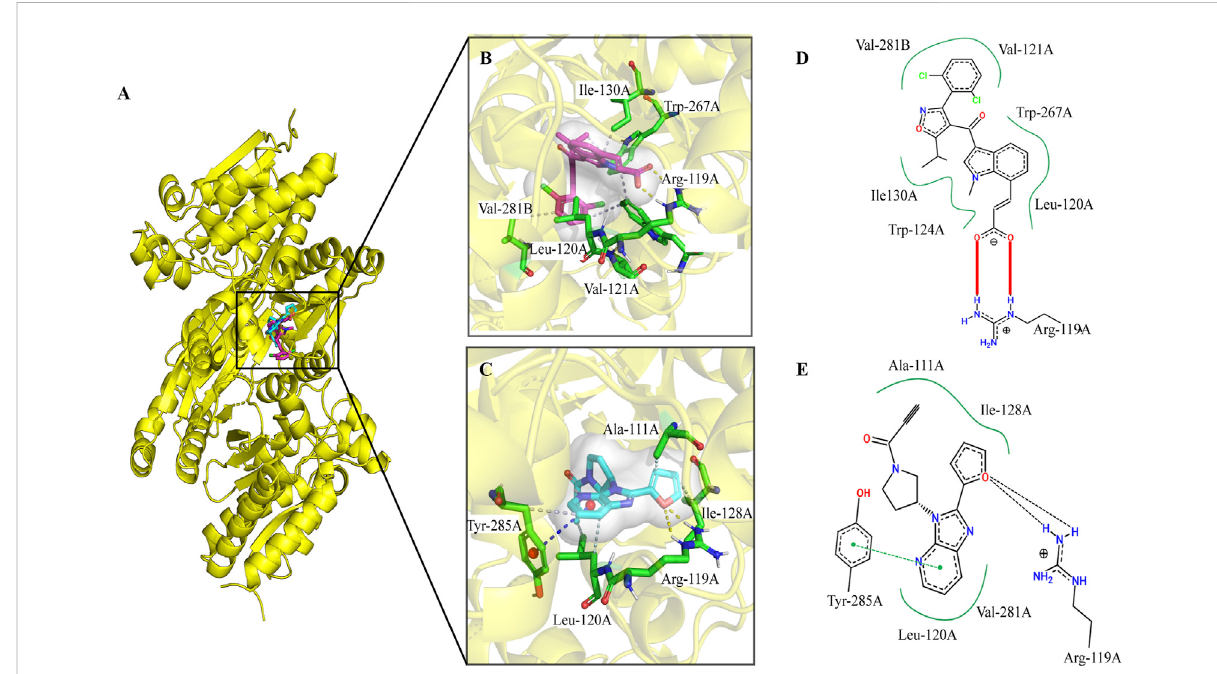
FIGURE 4 ThebindingpocketofcompoundAandT001-0657forIDH1-R132C. (A) Overall fi guresofthebindingofcompoundAandT001-0657to IDH1 - R132C.CompoundAisdepictedasredsticksandT001-0657isdepictedasbluesticks.The IDH1- R132Cisdisplayedincartoonmode(PDBID6IO0). (B,C) A close-up view of the key interactions stabilizing compound A/T001-0657 in the IDH1 -R132C binding pocket. Compound A/T001-0657 is depicted as red/blue sticks, the surrounding key residues are shown as green sticks and labeled. The hydrogen bonds are shown as a yellow dashed line. (D,E) Two-dimensional binding mode diagram of compound A and T001-0657 with IDH1 -R132C; the red solid line indicates the salt- bridgeinteraction,thegreendashedlineindicatesthe π - π